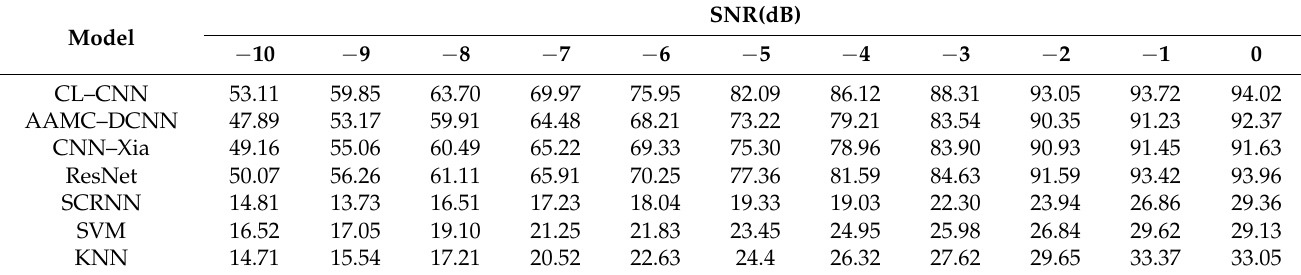
Table 11. Classification performances of the deep models and the traditional methods, with the sample size for each class being 55 based on the first dataset.